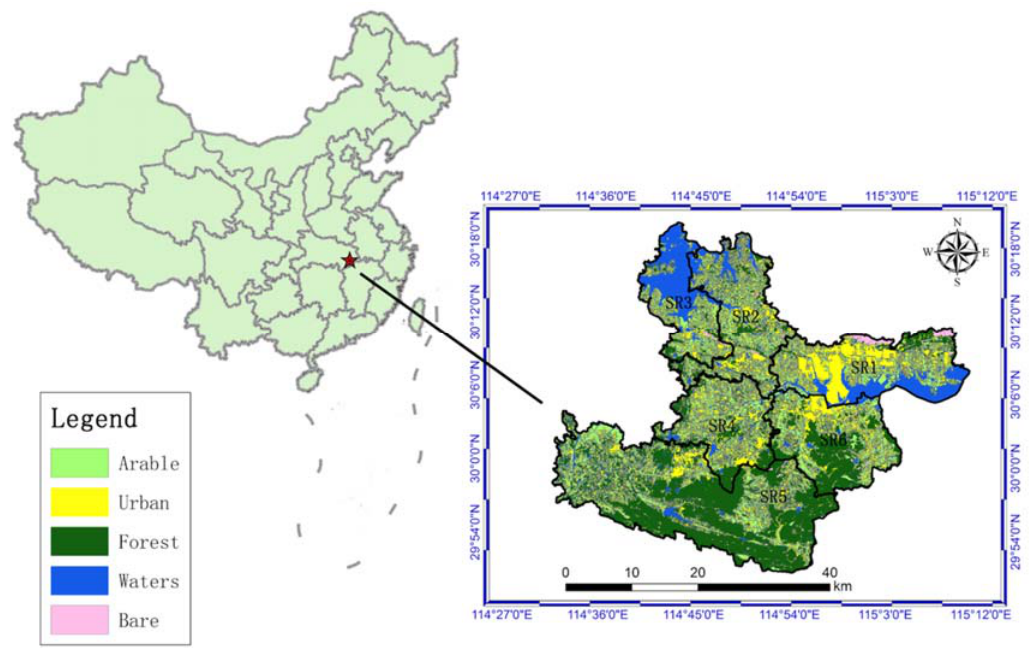
Figure 1. Land use map of Daye City and its sub-regions.